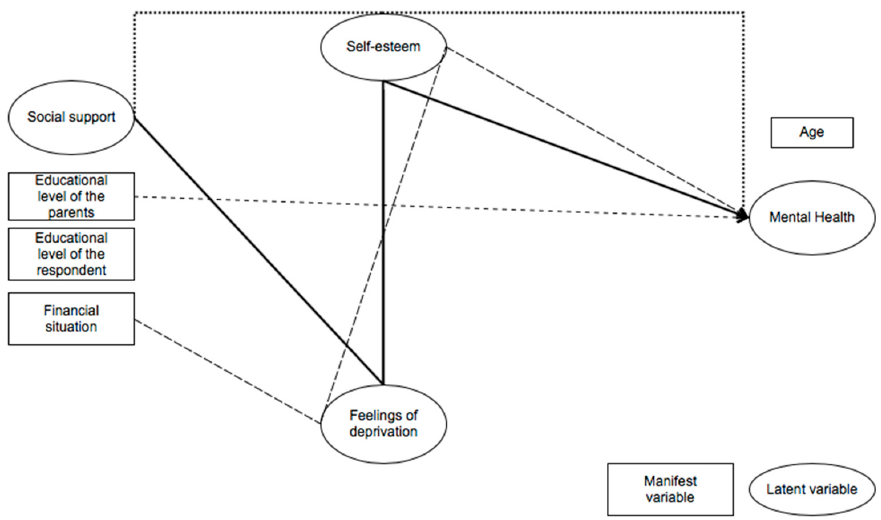
Figure 3. Visual representation of the different paths of the structural equation analysis—men. Note: Each path is represented with a different line. Estimates of the paths can be consulted in Table 4.